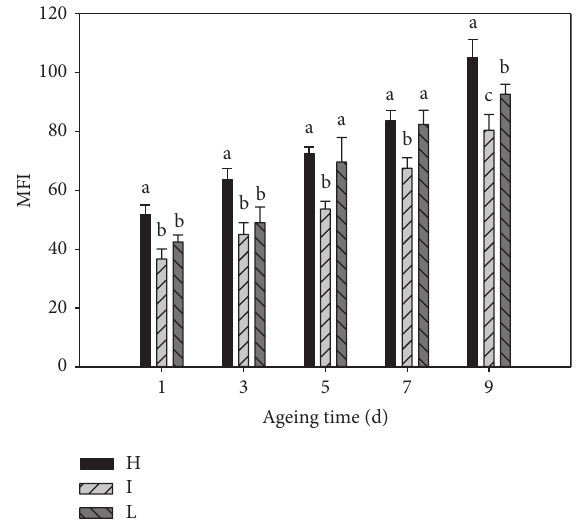
Figure 2: Effect of pHu and ageing time on myofibril fragmentation index of M. Longissimus dorsi samples from Chinese Yellow crossbreed cattle stored at 4 ∘ C. (H = high pHu group, meat pH > 6.2; I = intermediate pHu group, pH 5.8–6.2; L = low pHu group, pH < 5.8). Different letters at the same ageing time indicate significant differences ( 𝑃 < 0.05